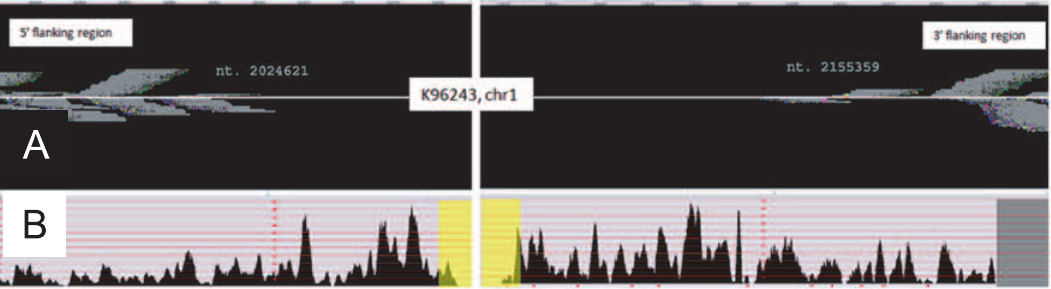
Figure 3. Large deletion verification in chromosome 1 of strain 708a by whole genome sequencing. Genomic sequencing data from strain 708a were aligned against the K96243 reference genome. Panel A shows the read density near positions 2,024,621 and 2,155,359 on chromosome 1. Panel B shows the 708a read density across the , 4.5 Kb flanking the deletion in chromosome 1 of strain K96243. The yellow highlighted region in panel B marks a , 130.7 Kb region with a near-zero read coverage, which correspond to the panel A coordinates. This lack of reads is strong evidence for deletion of the entire region in strain 708a.